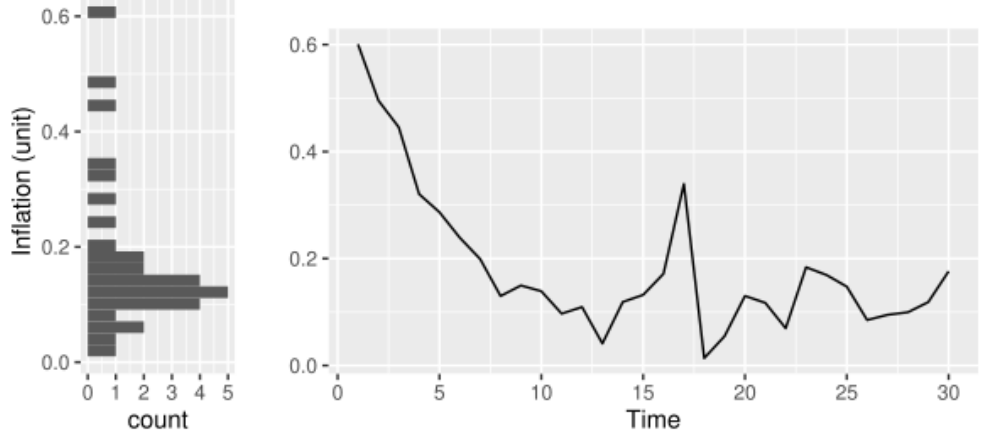
Figure 3. Chilean inflation in the period 1992–2021 (post-military era). The histogram on the left presents a skewness of the data. The dynamics is represented in the right panel, in which a disturbance (outlier) is observed in the year 2008 (observation #17).